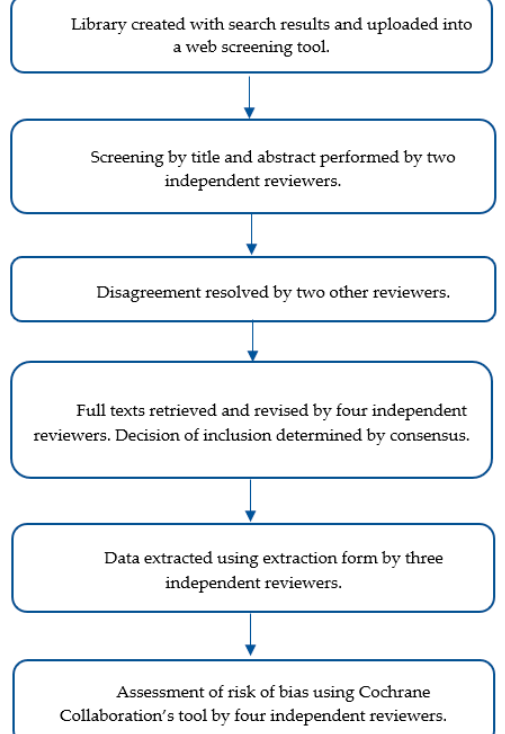
Nutrients 2019 , 11 , x FOR PEER REVIEW Figure 1. Flow chart representing the review process. Figure 1. Flow chart representing the review process.